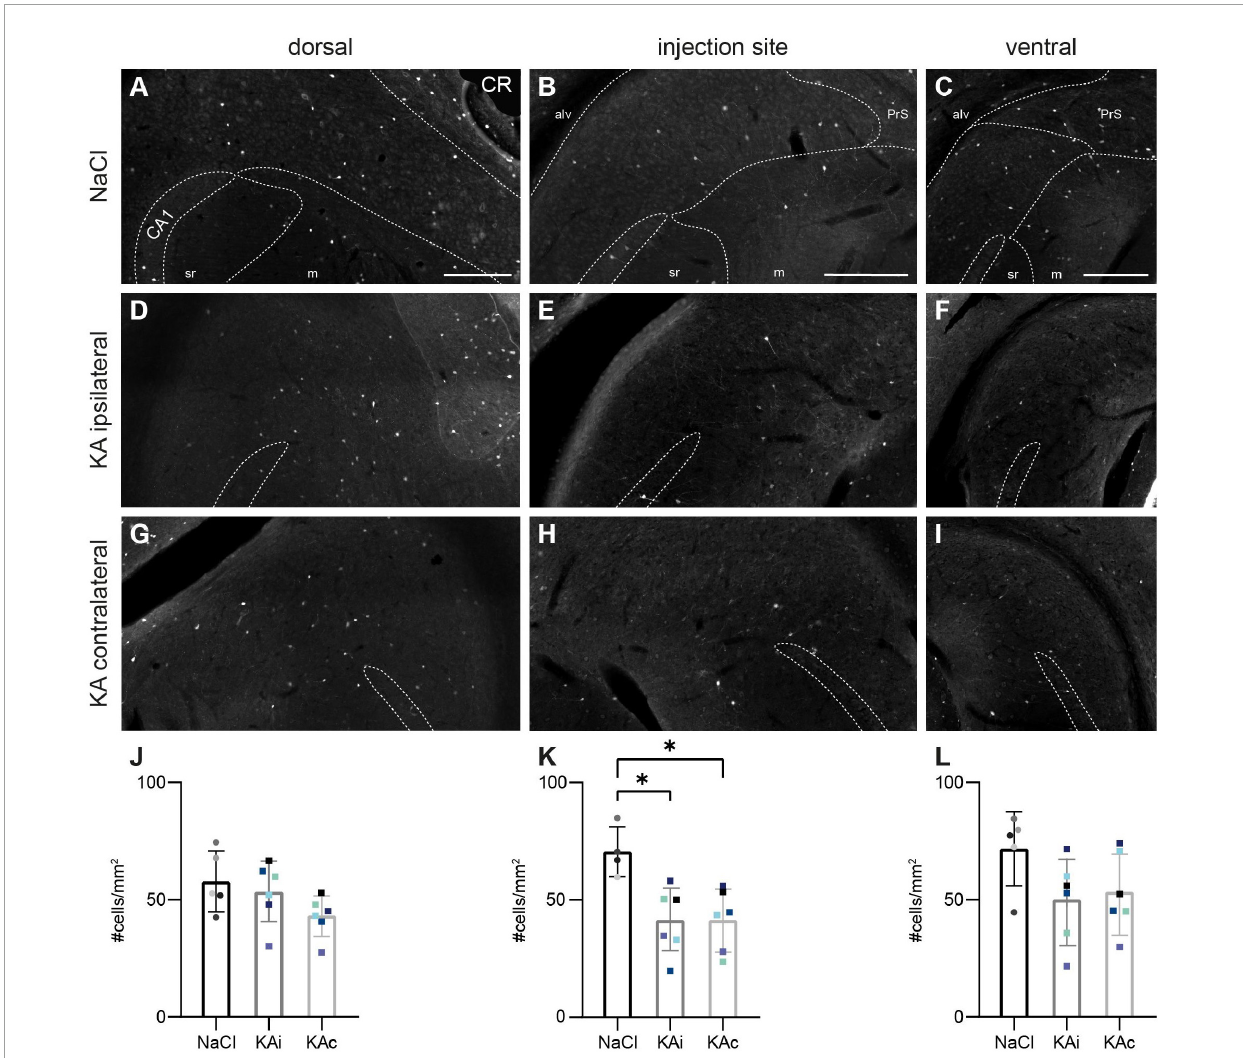
FIGURE4 Calretinin (CR)-expressing neurons are reduced 21 days after kainate (KA) injection. Representative sections immunostained for CR in control mice (A–C) and 21 days after KA injection (D–I) . The localization of the CA1 pyramidal cell layer is indicated. The borders of the subicular pyramidal cell layer toward the alveus (alv) and the molecular layer (m) are delineated as dashed lines according the brain atlas (Franklin and Paxinos, 2008). (A–C) In the subiculum of control animals CR + neurons are sparsely scattered throughout the pyramidal cell layer at the dorsal position (A) , the injection site (B) and more ventral (C) . (D) At 21 days after KA, the density and distribution of CR + cells is comparable to controls in the dorsal ipsilateral subiculum. (E) At the injection site, CR + cells are reduced throughout the pyramidal cell layer. (F) At the ventral position, the density of CR + cells is reduced in some, but not all mice. (G) In the dorsal contralateral subiculum, the density of CR + cells is comparable to control. (H) At the level of the injection site, CR + cells are reduced also on the contralateral side. (I) Further ventral, CR immunolabeling is comparable to the ipsilateral side with reduced density in some mice. (J–L) Quantification of CR + cells in the subiculum of NaCl-injected mice, ipsi- and contralateral subiculum of KA-injected mice 21 days after injection. Individual mice are color-coded, bars show means (cells/mm 2 ) with standard deviation (SD). (J) At the dorsal position the means of the three tested groups do not differ (one-way ANOVA: p = 0.138). (K) At the level of the injection site, the density of CR + cells is reduced at the ipsilateral and contralateral side compared to control (one-way ANOVA: p = 0.007; Tukey’s multiple comparisons test: NaCl-KAi p = 0.010, NaCl-KAc p = 0.012). (L) No significant differences at the ventral position (one-way ANOVA: p = 0.123). Scale bars: 250 µ m. ∗ p < 0.05. alv, alveus; CA1, cornu ammonis 1; m, molecular layer; PrS, presubiculum; sr, stratum radiatum